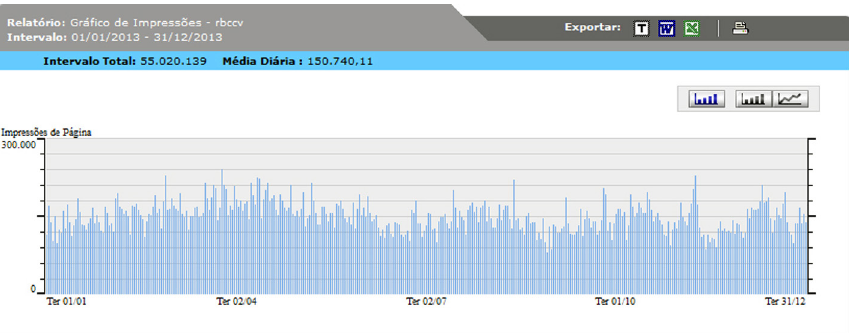
Fig. 2 – Graph showing page impressions of RBCCV / BJCVS site in